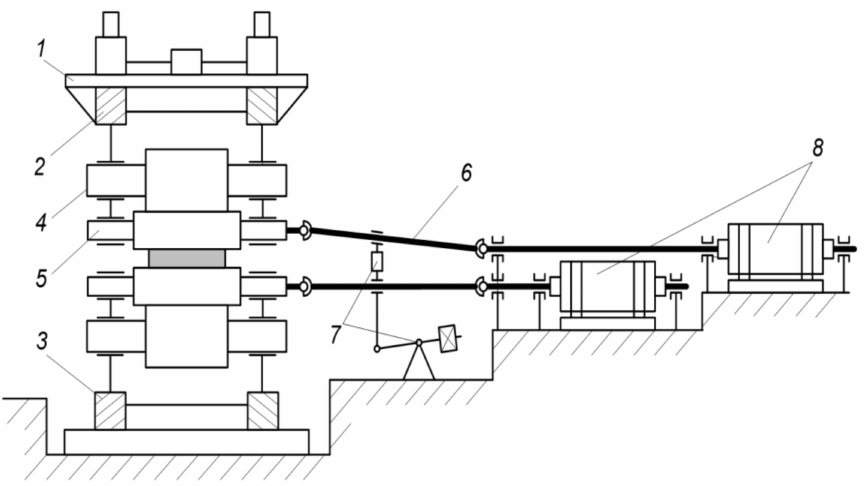
Figure 1. Kinematic diagram of the rolls: 1 is the frame; 2 and 3 are electromechanical and hydraulic screw-downs, respectively; 4 and 5 are the backup rolls and work rolls, respectively; 6 is retractable spindles; 7 is the counterbalance; 8 is motors.